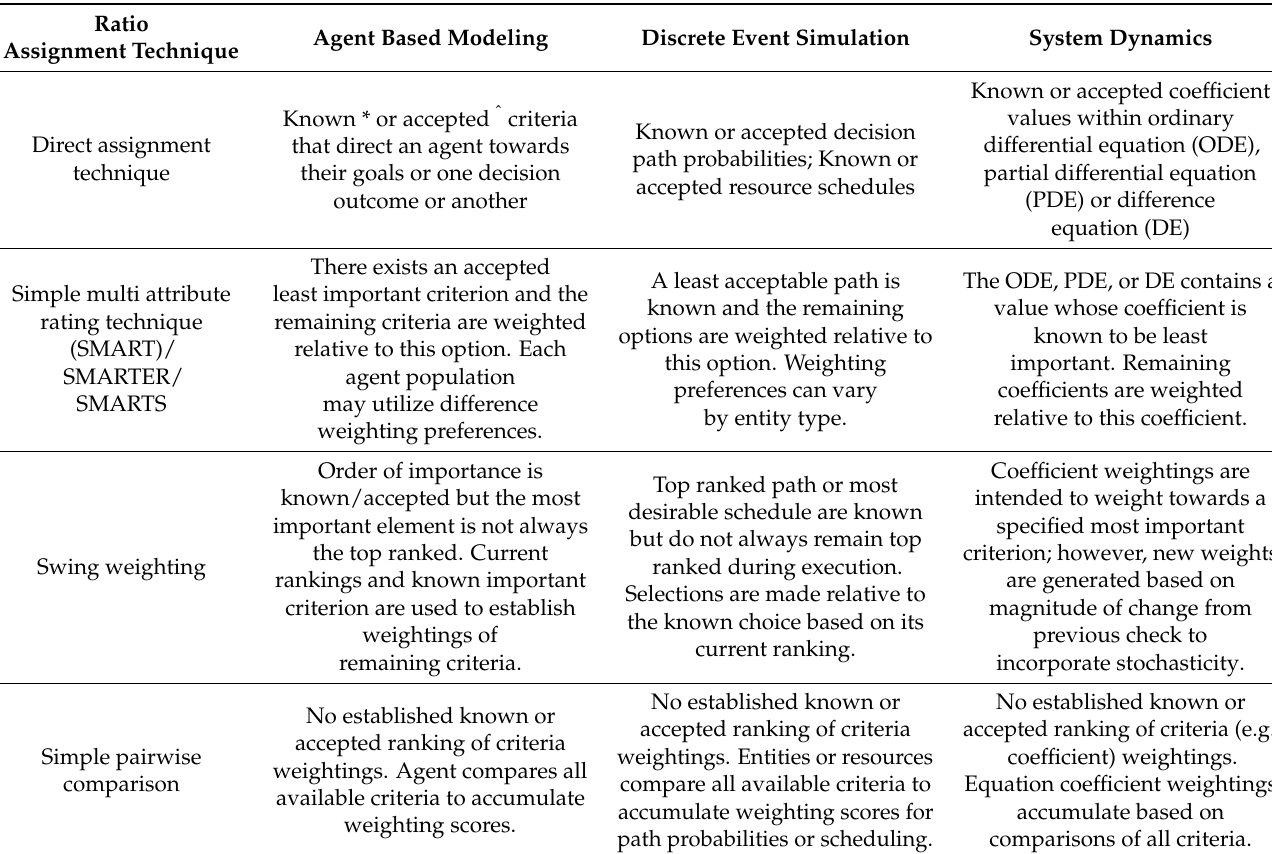
Table 18. Considerations for incorporating ratio assignment techniques into ABM, DES, and SD modeling